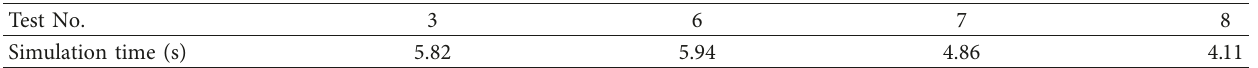
Table 5: Simulation times for the boundary entering cases 3, 6, 7, and